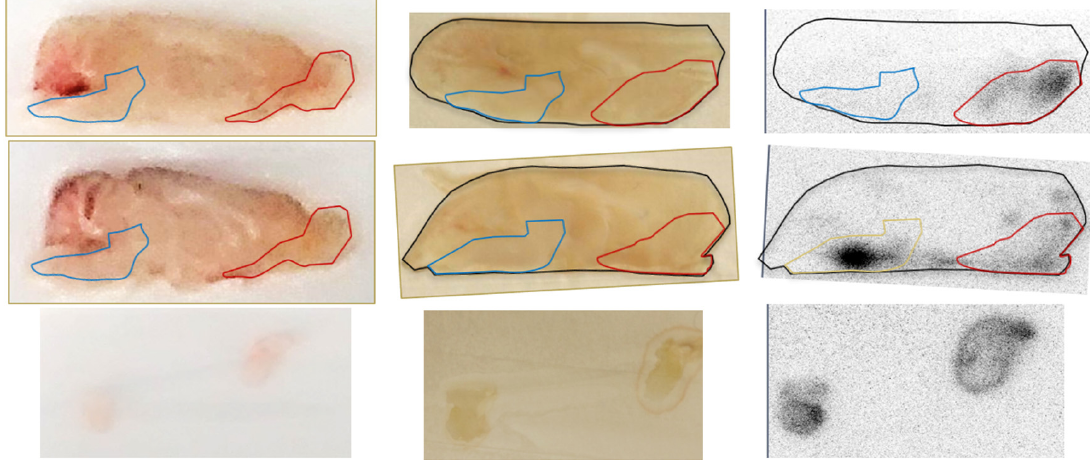
Figure 6. Ex vivo autoradiography of right and left paramedian sagittal brain slices at 2 h following INDD of polylactide (PLA) NPs. Two rat brains were made into 1–2 mm sections using rat brain slice matrices. The far left and middle images of the top and middle rows represent sagittal sections at 2 h following intranasal delivery of zirconium 89 ( 89 Zr)-labeled NPs before and after positioning against phosphor screens for 24 h prior to scanning. The far-right images are the radioactivity read outs collected on the film. The bottom row represents the trigeminal nerves isolated from a single rat with radioactivity present in this tissue as well.